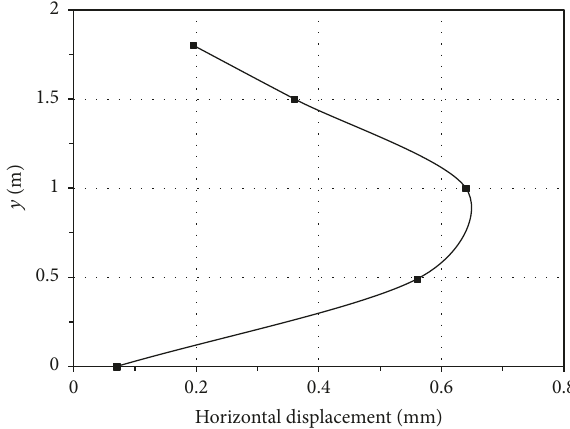
Figure 6: Relative displacement of the lateral wall of the